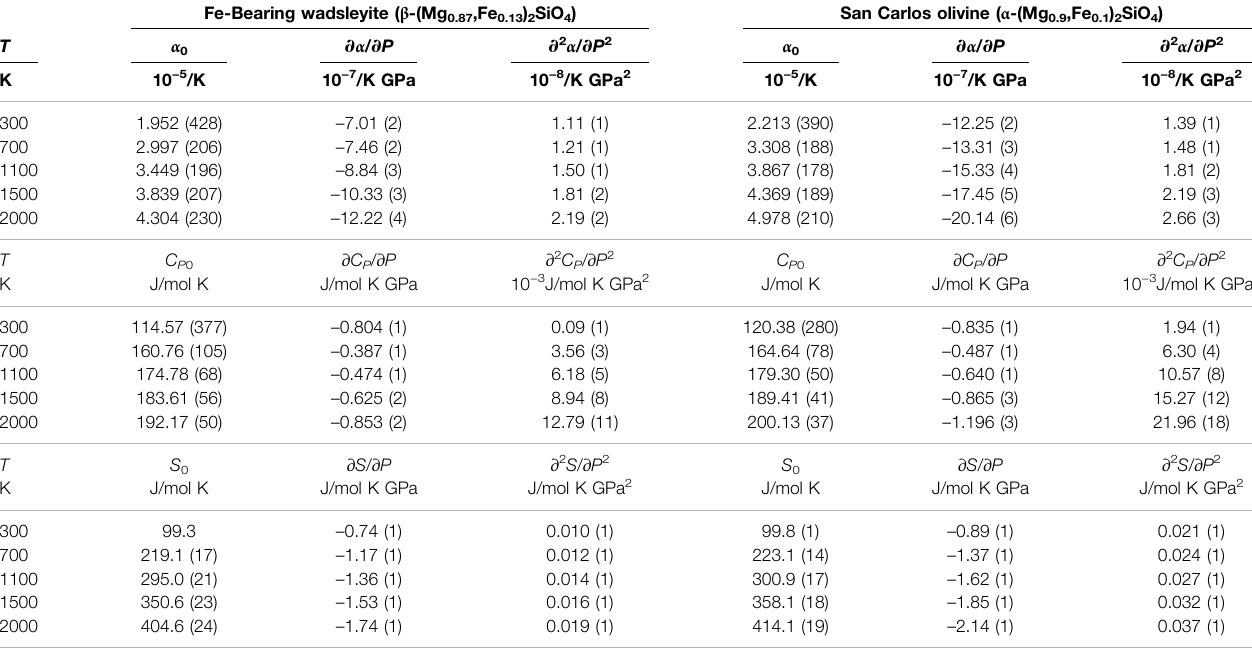
TABLE3| Thethermalexpansions,heatcapacities,andentropiesof β -(Mg 0.87 ,Fe 0.13 ) 2 SiO 4 and α -(Mg 0.9 ,Fe 0.1 ) 2 SiO 4 ,andtheirpressurederivativesatvarioustemperatures. Fe-Bearing wadsleyite ( β -(Mg 0.87 ,Fe 0.13 ) 2 SiO 4